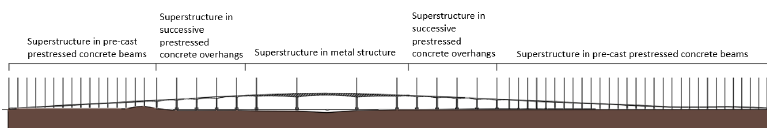
Figure 1. Third Bridge VIXBR general view.